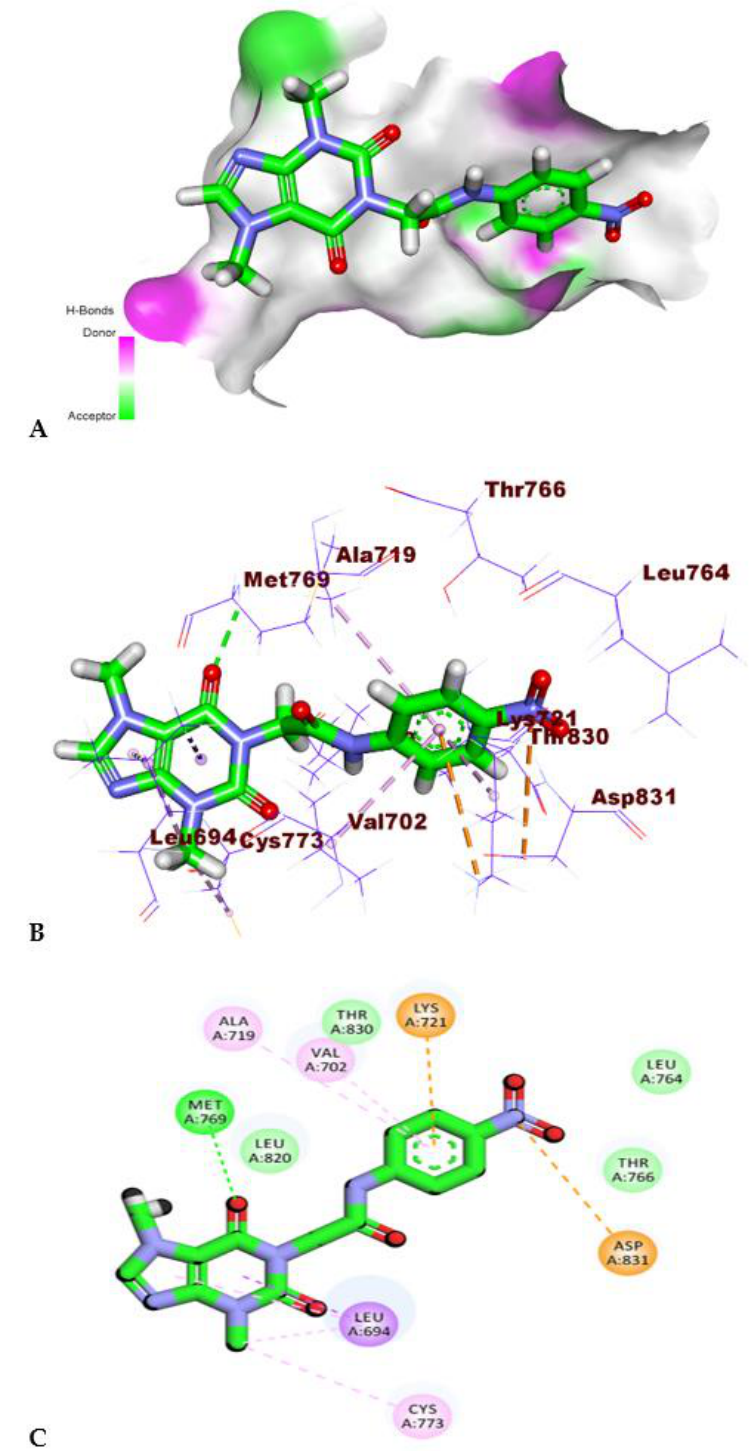
Figure 4. ( A ) Mapping surface (MS), ( B ) 3D, and ( C ) 2D interaction pattern of T-2-PNPA with EGFR WT active site.